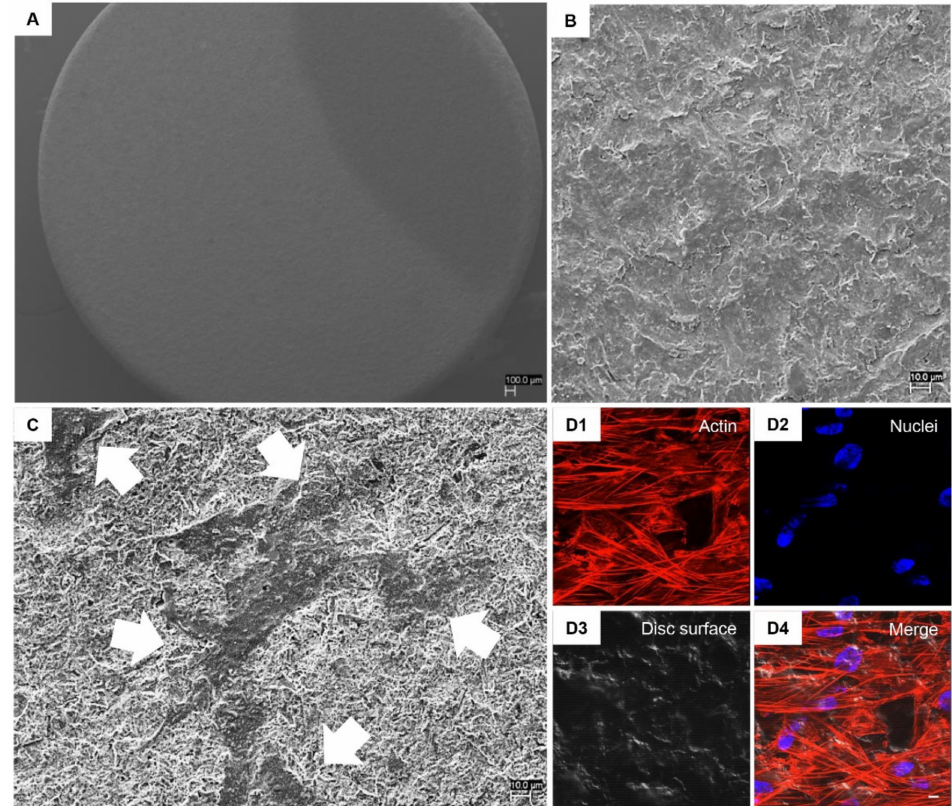
Figure 3. ( A ) SEM observations of TEST surface without cells captured at 50 × magnification. ( B ) SEM observations of TEST surface without cells captured at 1000 × magnification. ( C ) SEM observations of hPDLSCs cultured on TEST surface captured at 1000 × magnification. This picture was taken from the paper published [14]. ( D1–D4 ) CLSM observation of hPDLSCs cultured on TEST surface. ( D1 ) Cytoskeleton actin stained with Alexa Fluor 594 phalloidin and observed under red fluorescence channel; ( D2 ) Nuclei stained with TOPRO and observed under blue fluorescence channel; ( D3 ) TEST surface observed under light transmission channel; ( D4 ) merged image of above mentioned channels. Scale bar: 20 µ m. White arrows indicate adherent cells on TEST